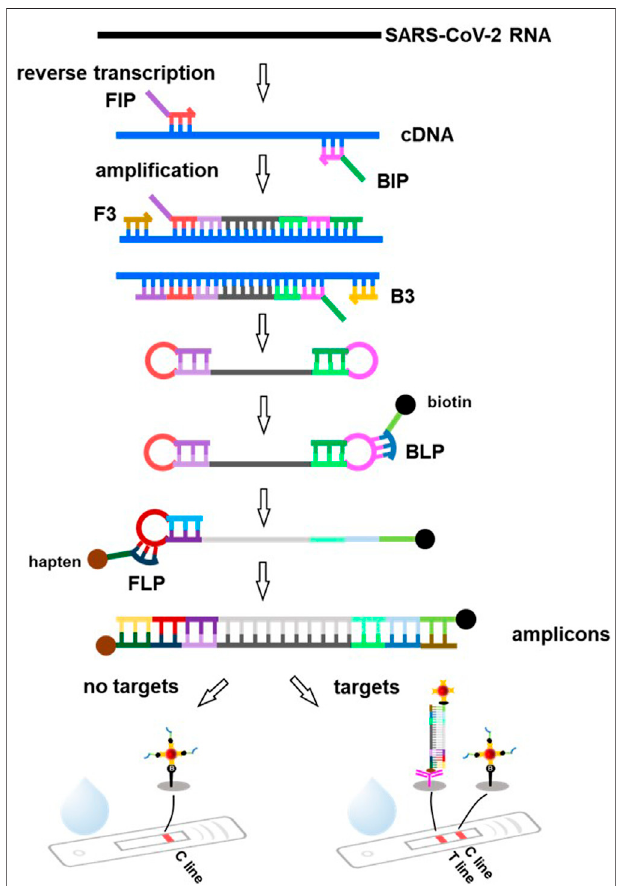
FIGURE 4 | Principle of the lateral fl ow assay based on RT-LAMP technique. SARS-CoV-2 RNA is reverse transcribed to cDNA, followed by speci fi c ampli fi cation with the forward inner primer (FIP), backward inner primer (BIP) and forward primer (F3), backward primer (B3), producing a great many of dumbbell-shaped product. These products are used as templates and ampli fi ed by speci fi c labeled primers backward loop primer (BLP), forward loop primer (FLP, such as hapten, biotin) to produce amounts of amplicons. As the ampli fi ed products migrate along the FLA strip, the conjugationsofampliconsandstreptavidincoatedAuNPscanbecapturedby the capture antibody immobilized at the T line, leading to a red visible signal. The excess BLP primers labeled biotin coupled with streptavidin-coated AuNPs keep moving and are captured by biotin immobilized at the C